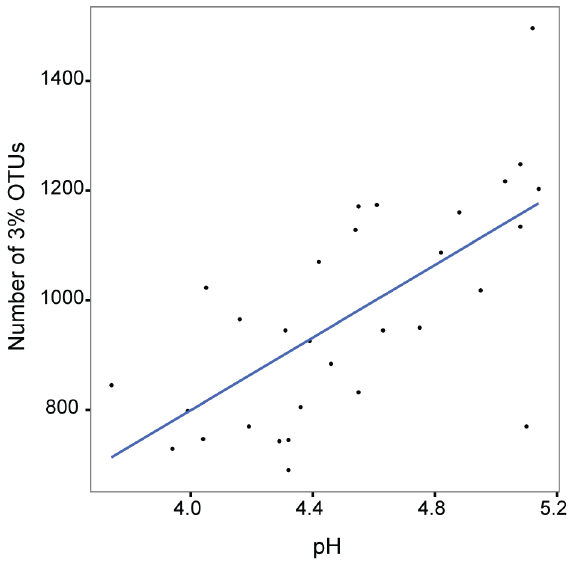
Figure 3. Richness and soil pH. Bacterial community richness is shown as the number of 3% OTUs. Pearson’s r =0.66, p , 0.0001.